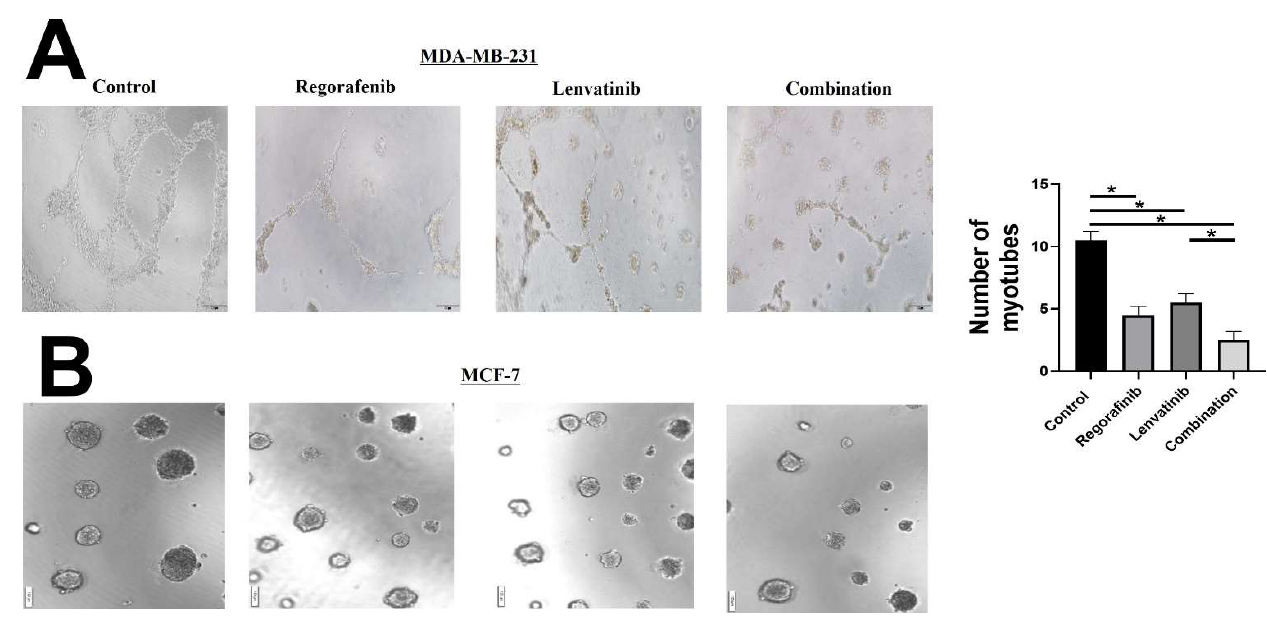
Figure 5. Effect of Regorafenib, Lenvatinib and combination treatment on tube formation assay in the ( A ) MDA-MB-227 and ( B ) MCF-7 cells. There was no tube formation in control group of MCF-7 cells. * Statistically significant, p -value < 0.05.